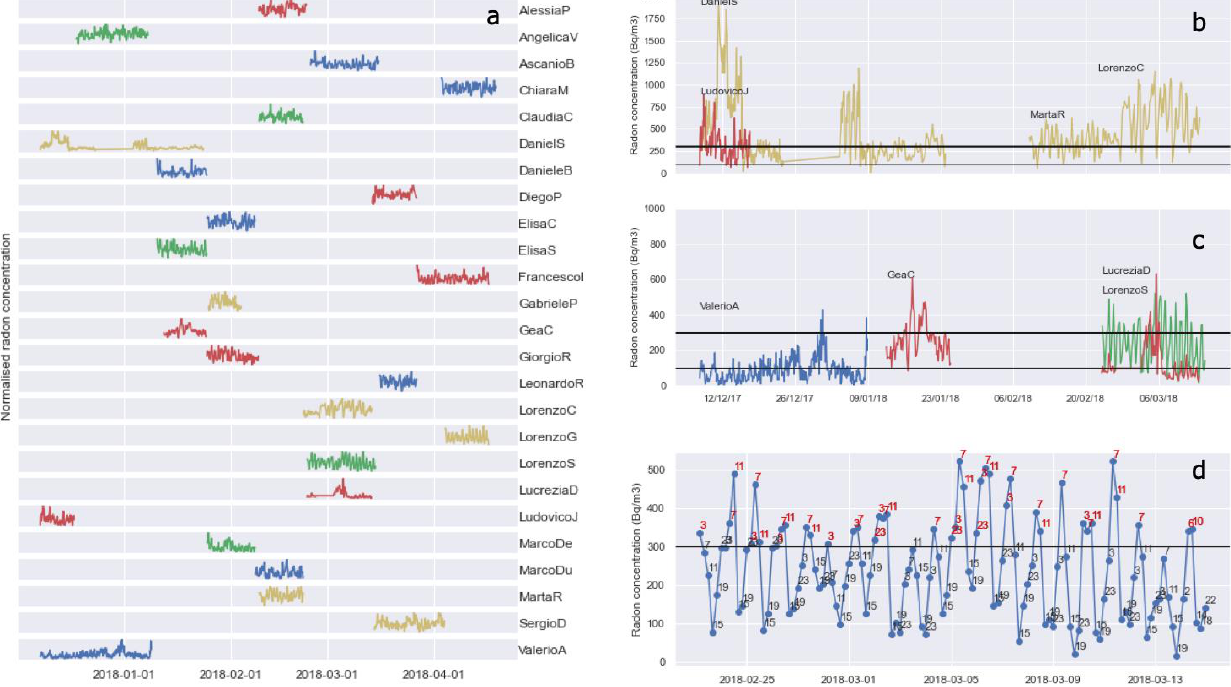
Figure 2. ( a ) Time series of normalized radon concentration recorded in 25 apartments. The four instruments employed (indicated by colors red, green, blue, and yellow) remained in each location for about two weeks, over the interval December 2017–April 2018. ( b ) Time series of radon concentration with average radon exceeding the EURATOM—recommended threshold of 300 Bq/m 3 (thick black line). The WHO—recommended threshold of 100 Bq/m 3 is shown as a thin black line). ( c ) Time series with average radon level below the threshold of 300 Bq/m 3 and maximum radon level exceeding it. ( d ) Radon time series measured in LorenzoS apartment. The hour of recording is indicated for each single radon data, with red labels indicating values exceeding 300 Bq/m 3 .